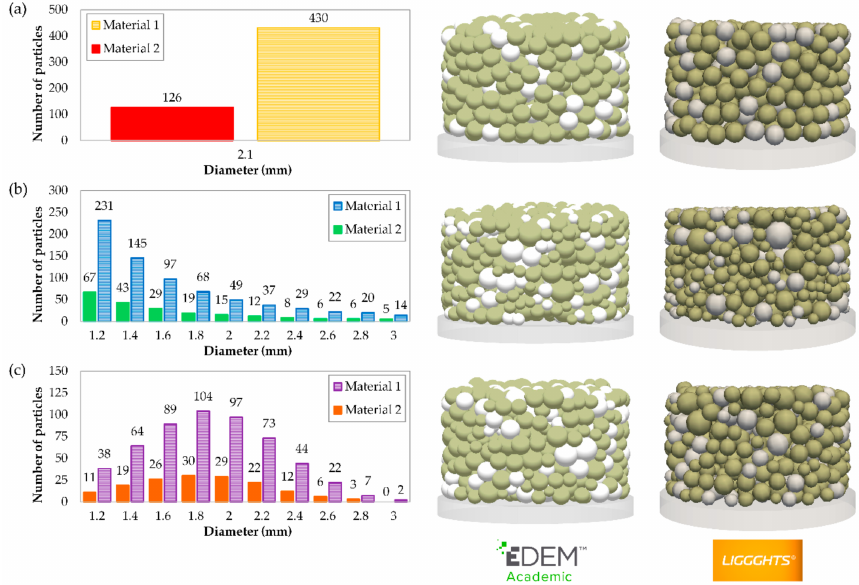
Figure 3. Number of particles used in the DEM simulations and the appearance of compacts obtained in both software programs with different particle size distributions (PSDs): ( a ) monosized particles (MP), ( b ) uniform distribution (UD), and ( c ) normal distribution